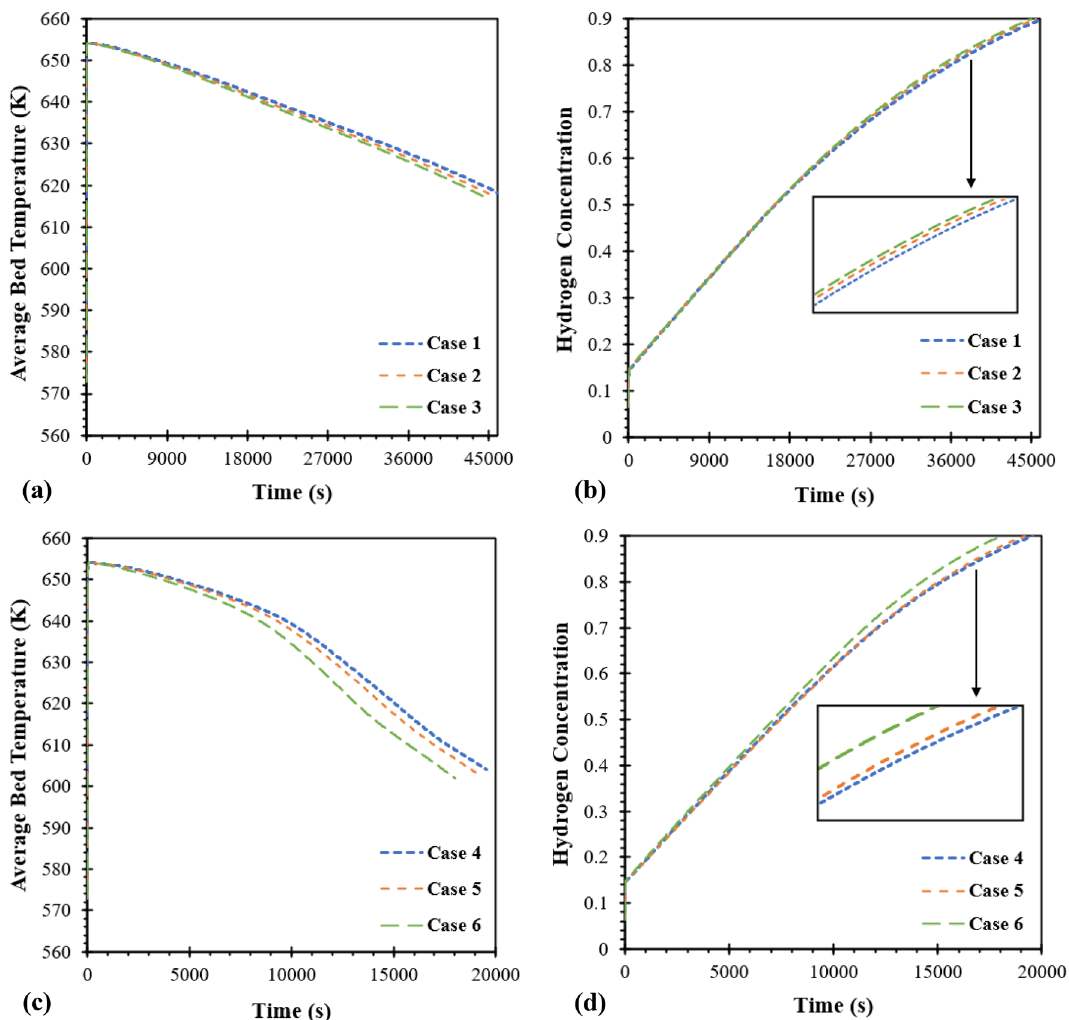
Figure 4. Effect of coil pitch on average bed temperature and hydrogen concentration. ( a ) Average bed temperature for helical coil pitch, ( b ) hydrogen concentration for helical coil pitch, ( c ) average bed temperature for semi-cylindrical coil pitch, and ( d ) hydrogen concentration for semi-cylindrical coil